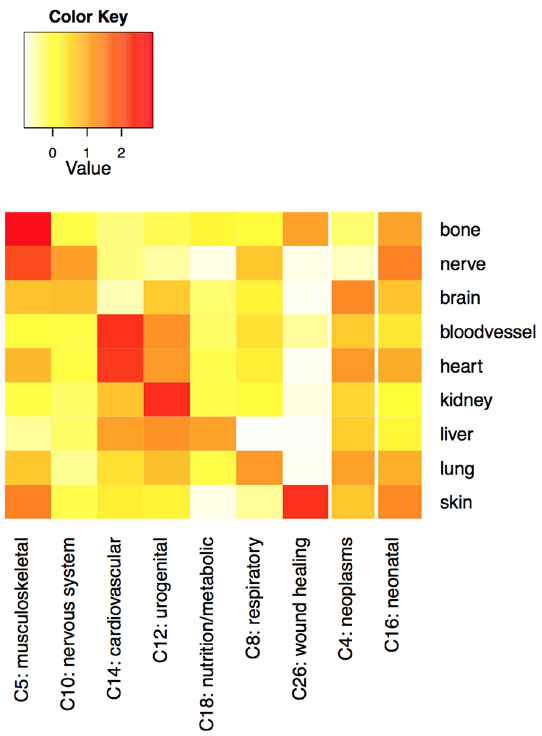
Figure 5. Expected results by tissue. Density of enrichment of developmental gene sets (labels on the right) in major disease subtrees. Values are z-score normalized densities, computed as described in Methods. Darker squares indicate that a larger fraction of the disease terms in the MeSH category have significant enrichment ( p v 0 : 005 ) of genes in the indicated gene set. Expected connections appear approximately along the diagonal in the first 7 columns, and throughout the rightmost two